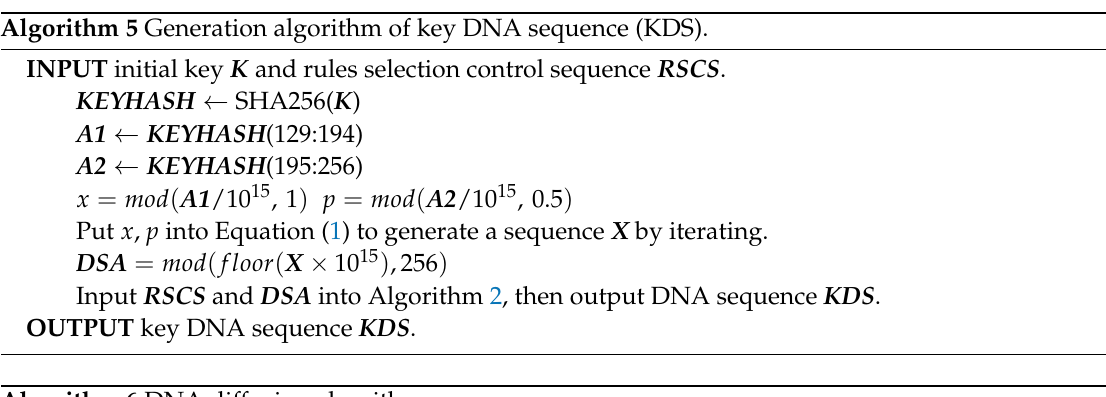
Algorithm 6 DNA diffusion algorithm.